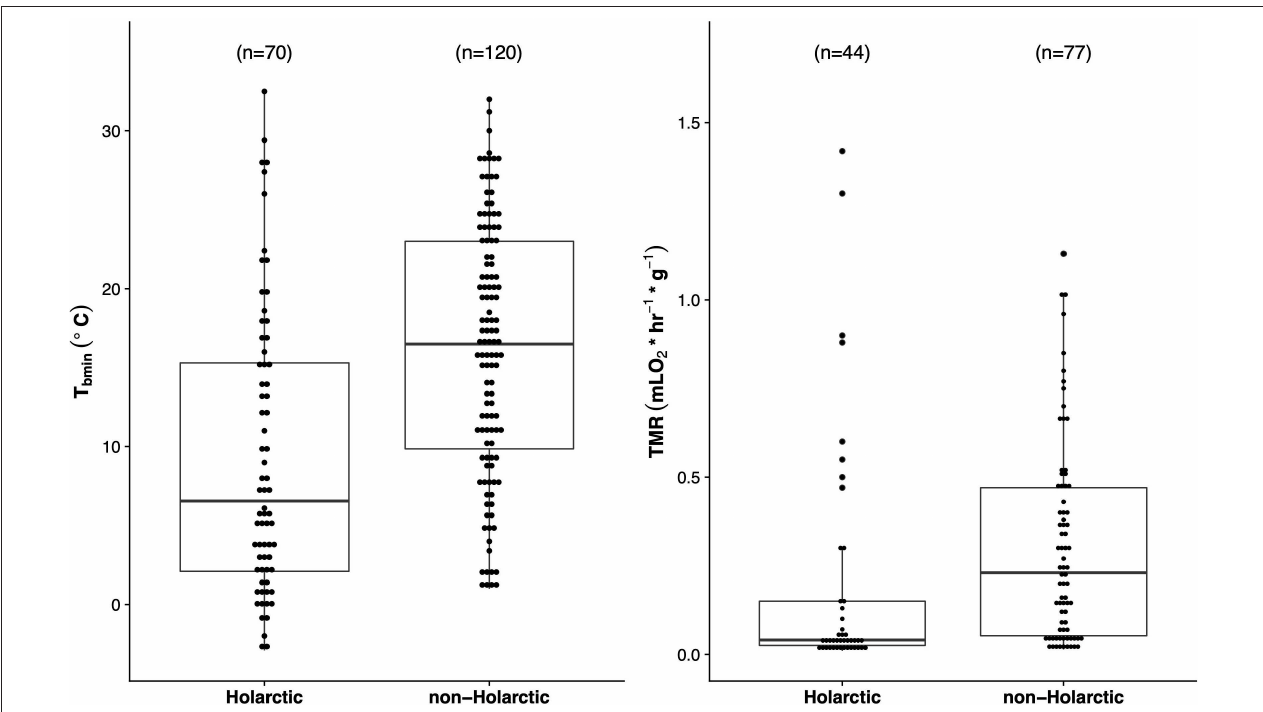
FIGURE 3 | Boxplots (representing the minimum, maximum, median, first quartile and third quartile) of minimal torpid body temperatures (T b ; ◦ C) and minimal torpid metabolic rate T b min for the non-Holarctic species with additional Holarctic species described by Ruf and Geiser (2015). Values for both were, on average, significantly higher in non-Holarctic species (see